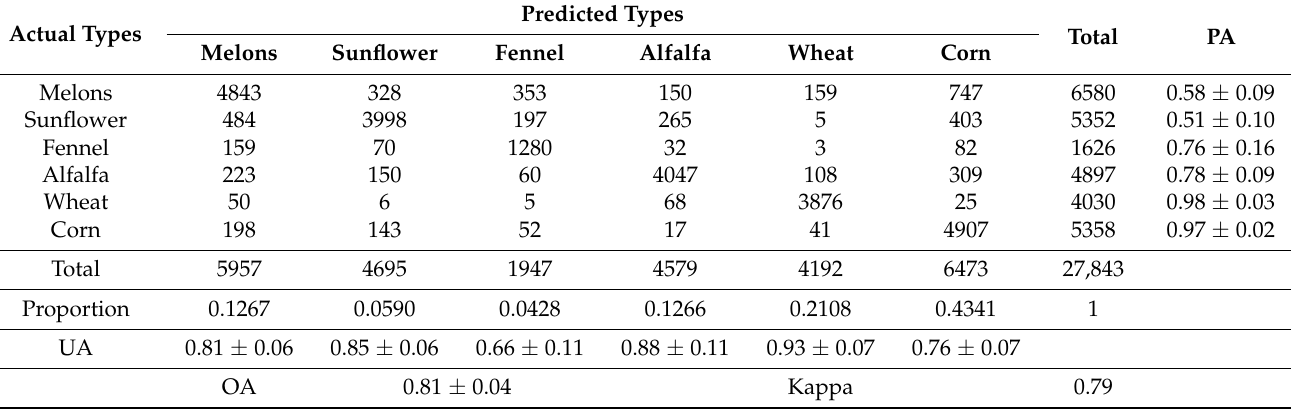
Table 3. Confusion matrix of the early-season crop map for 2020 in the Shiyang River Basin obtained using the Conv1D network. The proportion calibration and 95% confidence interval calculation were based on the method of Olofsson et al. [55] for the PA, UA, and OA using the map accuracy library in the R language. The proportion was calculated by using the pixel number of each crop in the predicted map. To calculate the 95% confidence intervals, the sample size was set to 654, which is the total number of independent samples from the different crop plots, to avoid excessively narrow confidence